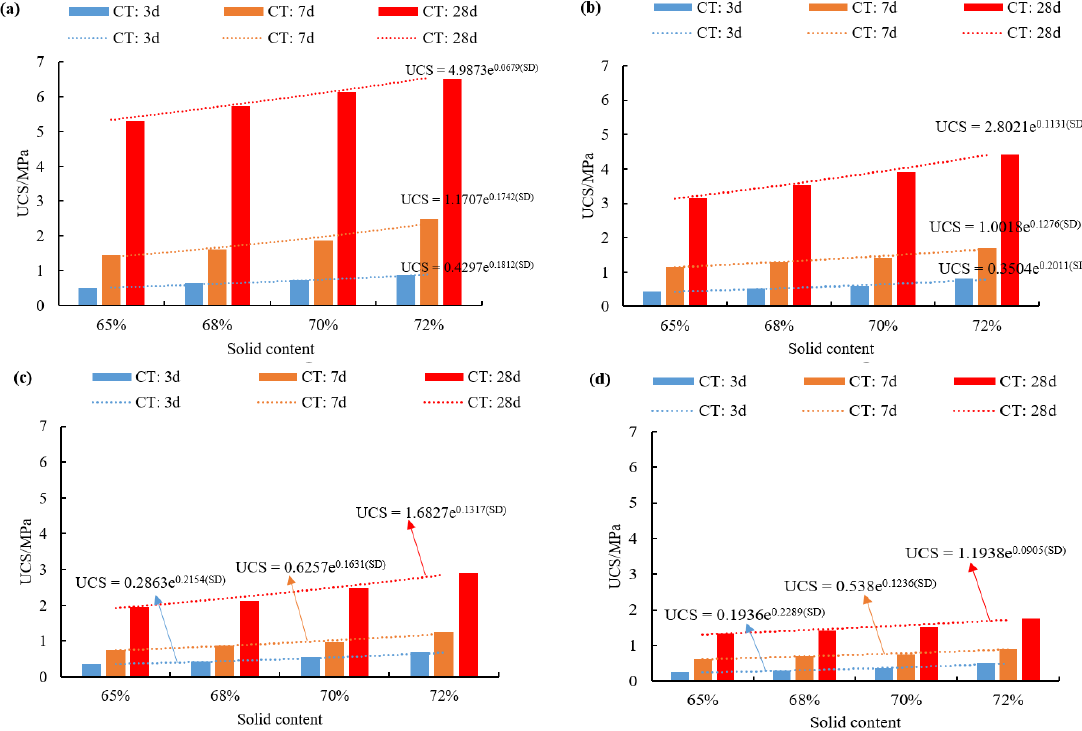
Figure 8. Relations between SD and UCS of CTB: ( a ) c/t: 1:04; ( b ) c/t: 1:06; ( c ) c/t: 1:08; ( d ) c/t: 1:10.